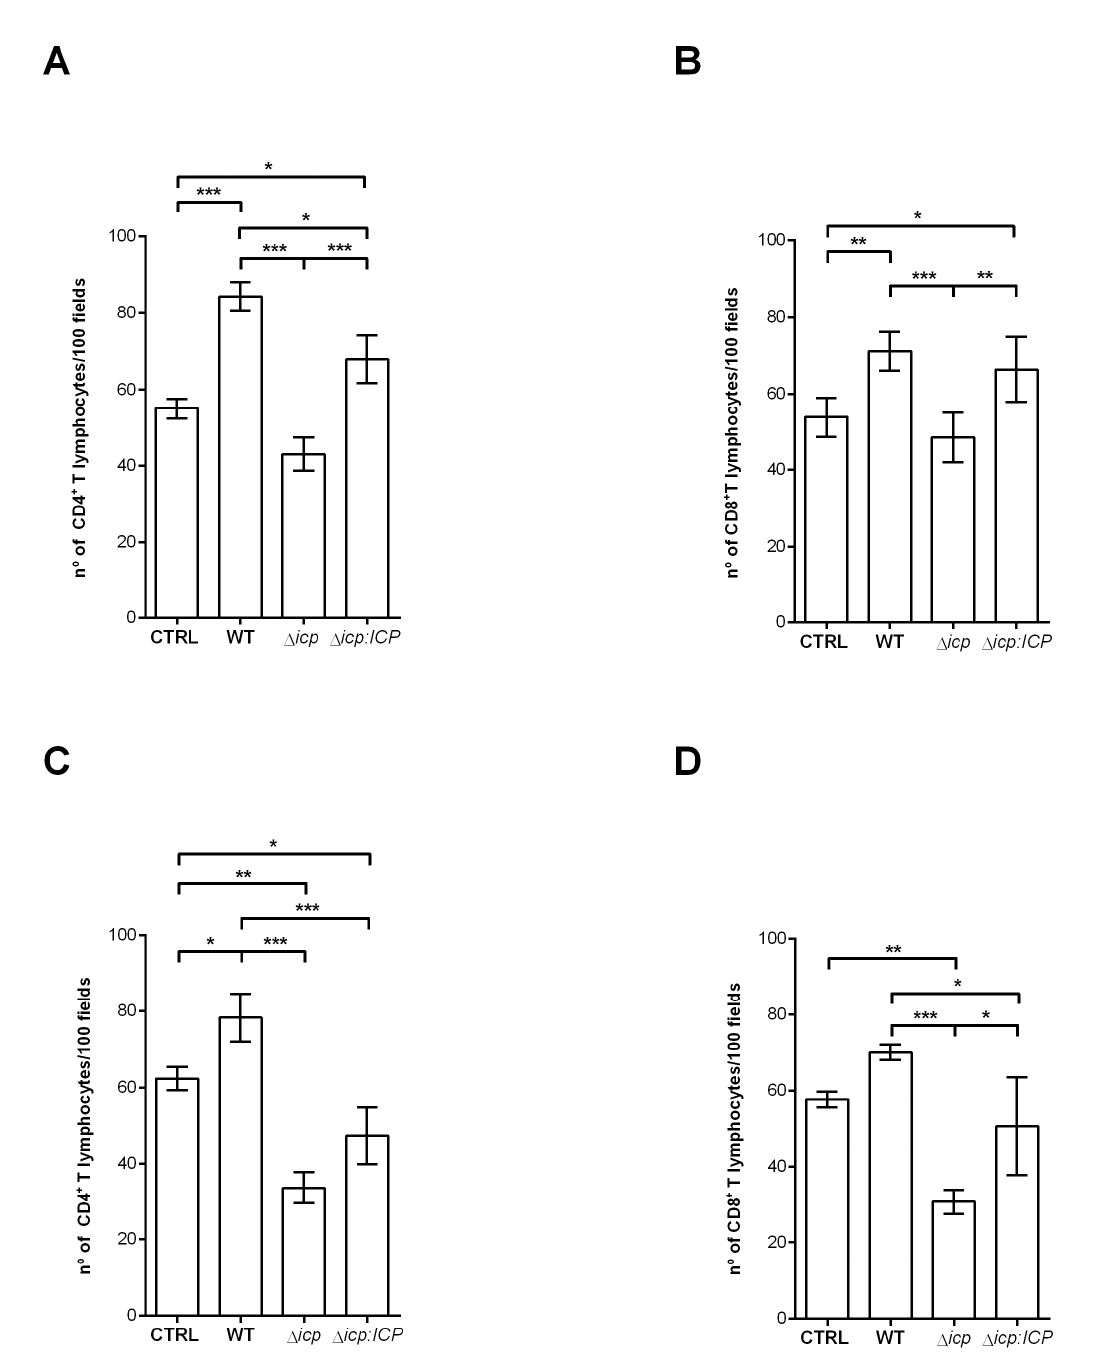
ing the interaction with T lymphocytes.